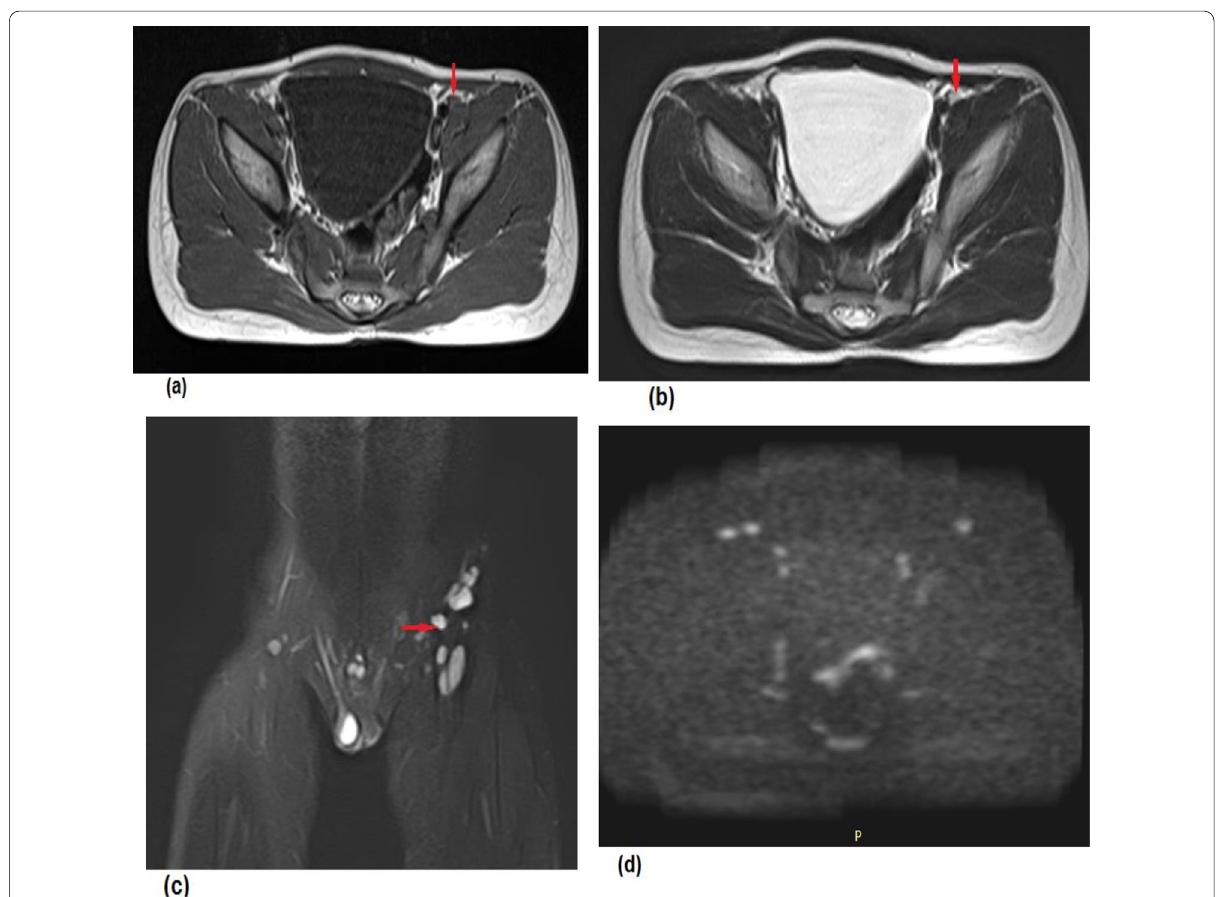
Fig. 2 A five-year-old boy complaining of left non-palpable undescended testis since birth. MRI findings a axial T1-weighted image, b axial T2-weighted image, c coronal STIR image showing left atrophic undescended testis seen in the left iliac region lateral to the iliac vessels measure 5.45 3.6 mm; it displays hypo-intense signal on T1W1, hyper-intense signal T2W2 and hyper-intense signal on STIR. DWIs finding : d Axial × diffusion-weighted image the left undescended testis not seen at b -value 800 s/mm 2 . Final diagnosis : left atrophic low intraabdominal UDT. = Surgery : Laparoscopy revealed atrophic intraabdominal testis and orchiectomy was